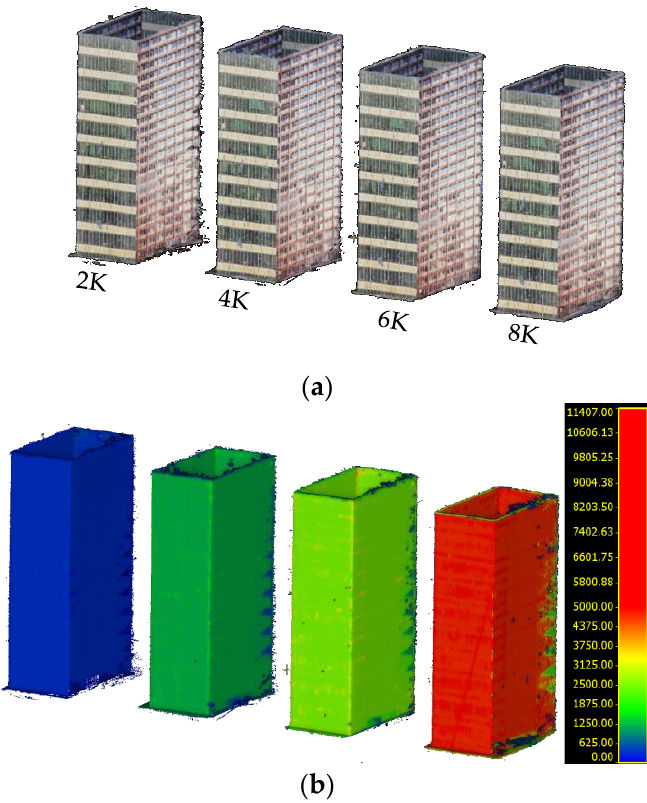
Figure 13. ( a ) The point clouds created from the video frames graduating from low to high resolution (left to right). ( b ) The estimated point densities where the red color indicates > 5000 pts/m 2 .